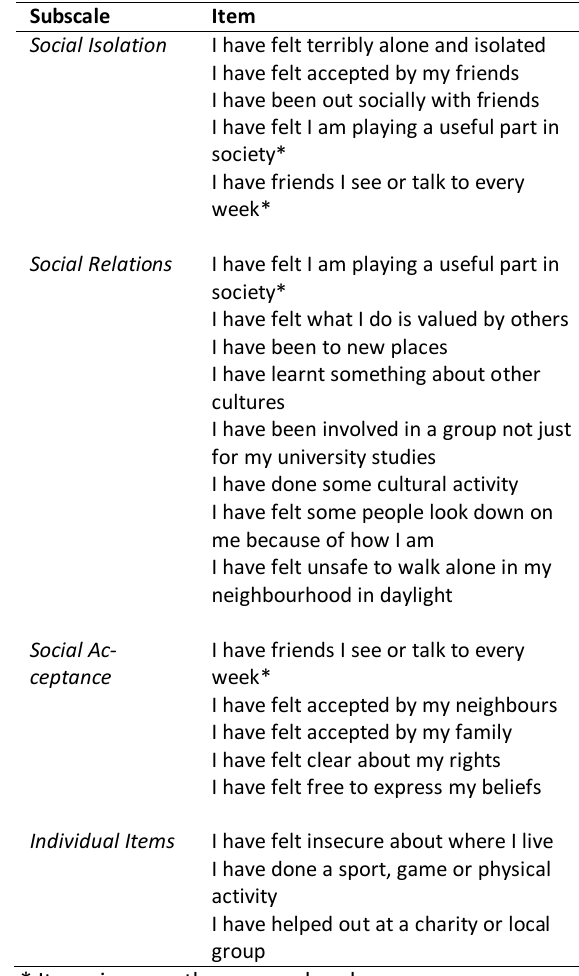
Table 1. SIS items and